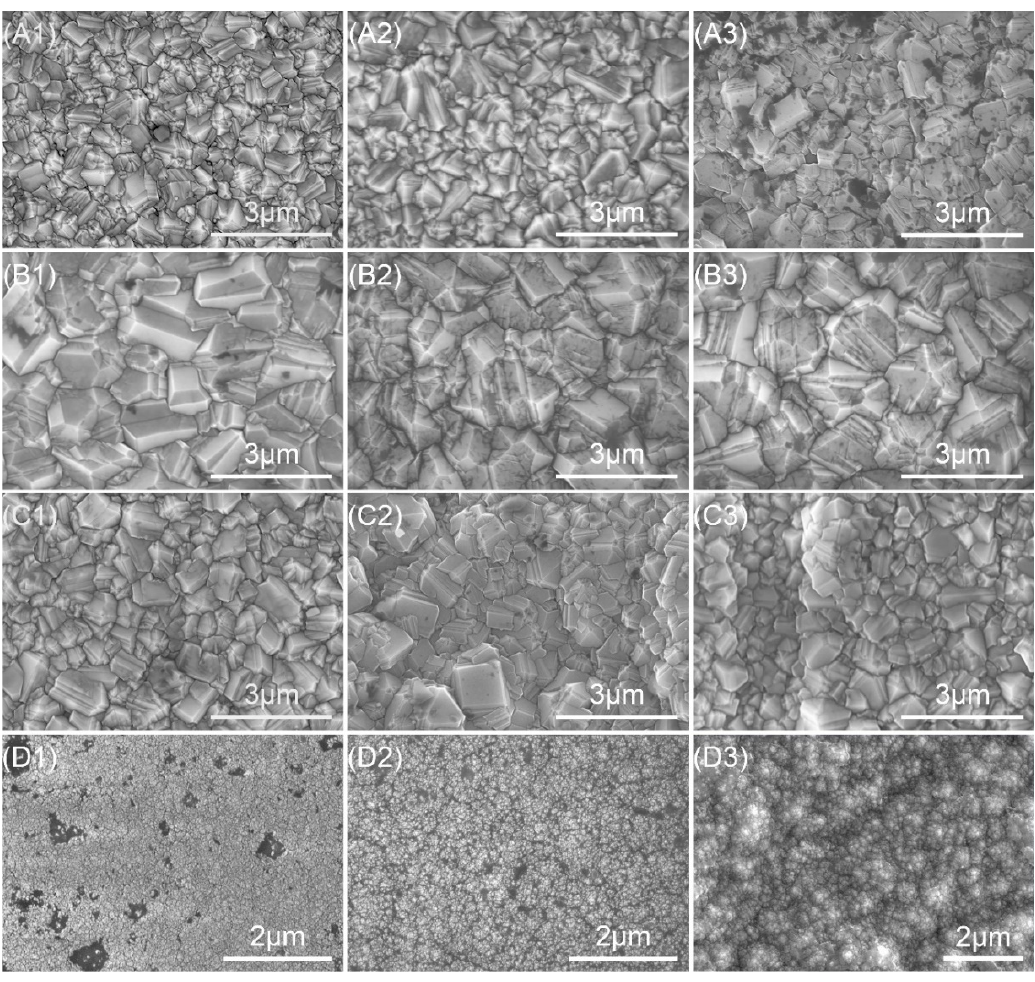
Figure 1. The surface morphology of diamond films.